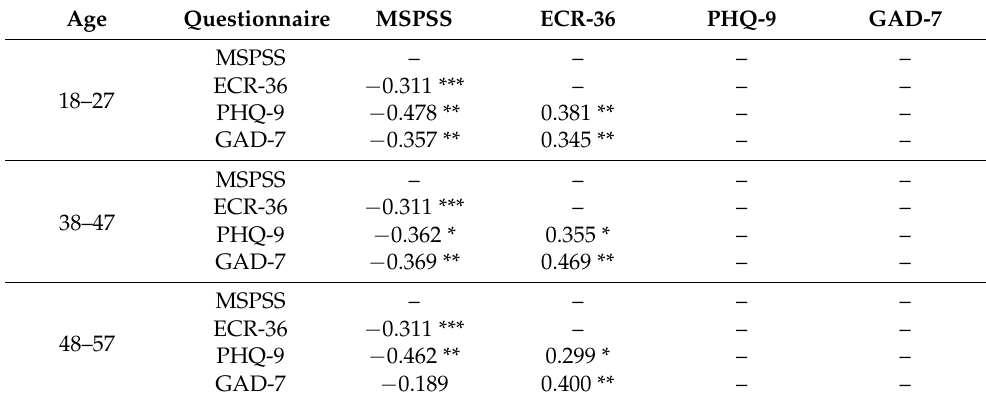
Table 3. Pearson correlations between the variables used in the mediation model dividing by main age